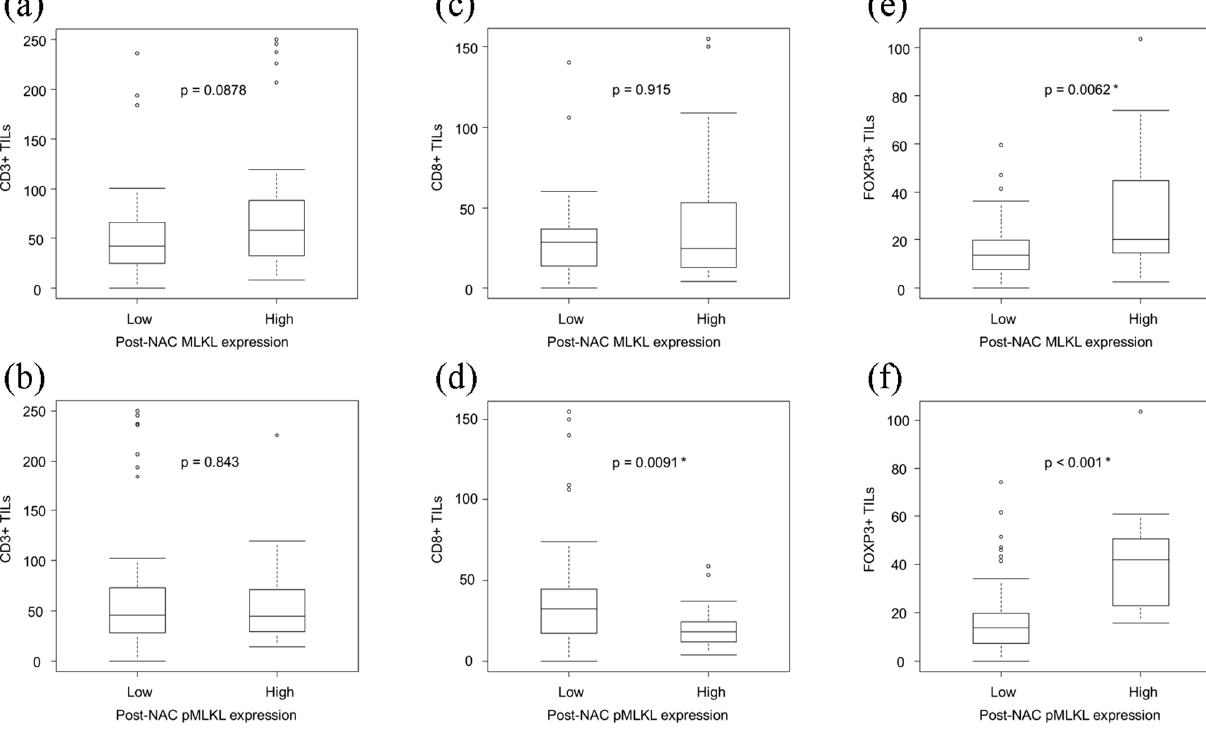
Figure 5. Representative illustrations of tumor-infiltrating lymphocytes (TILs). ( a ) Low CD3+ TILs, and ( b ) high CD3+ TILs. ( c ) Low CD8+ TILs, and ( d ) high CD8+ TILs. ( e ) Low FOXP3+ TILs, and ( f ) high FOXP3+ TILs. * Statistical signifi- cance.